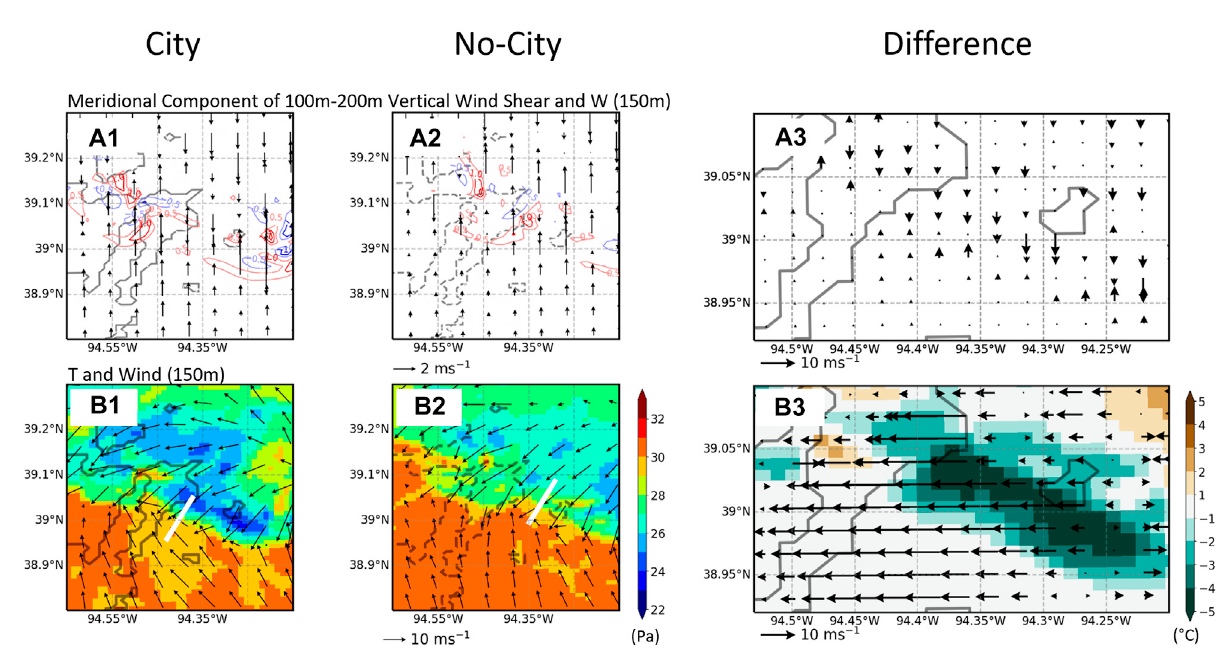
FIGURE 9 Vertical velocity at 150 m (contour lines) overlaid on the meridional component of 100m – 200 m vertical wind shear (barbs) for (A1) City, (A2) No- City, and (A3) the difference between City and No-City at 23:30 UTC. (B1 – B2) 150 m temperature (contour) and wind (barbs) fi elds. (B3) Shows the difference in the storm-relative zonal wind. The temperature gradients in the two simulations are calculated along the white lines in (B1) and (B2)